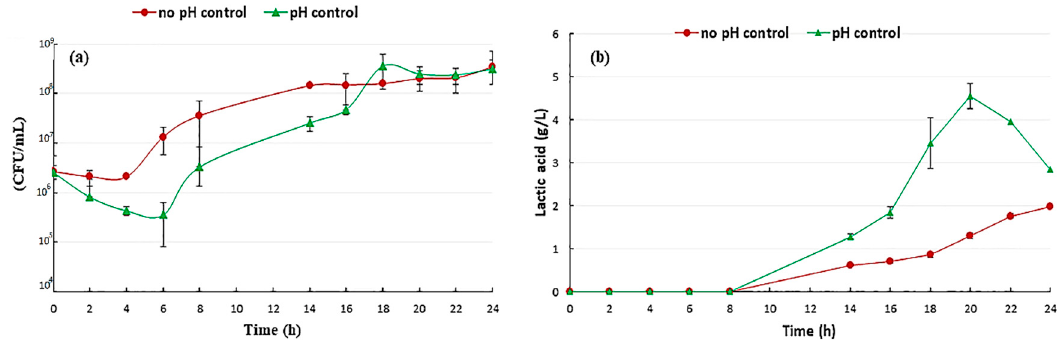
Figure 1. Bacterial growth ( a ) and lactic acid production ( b ) curves during rice flour fermentation carried out with and without pH control. Data were taken from Gallo et al. [11].